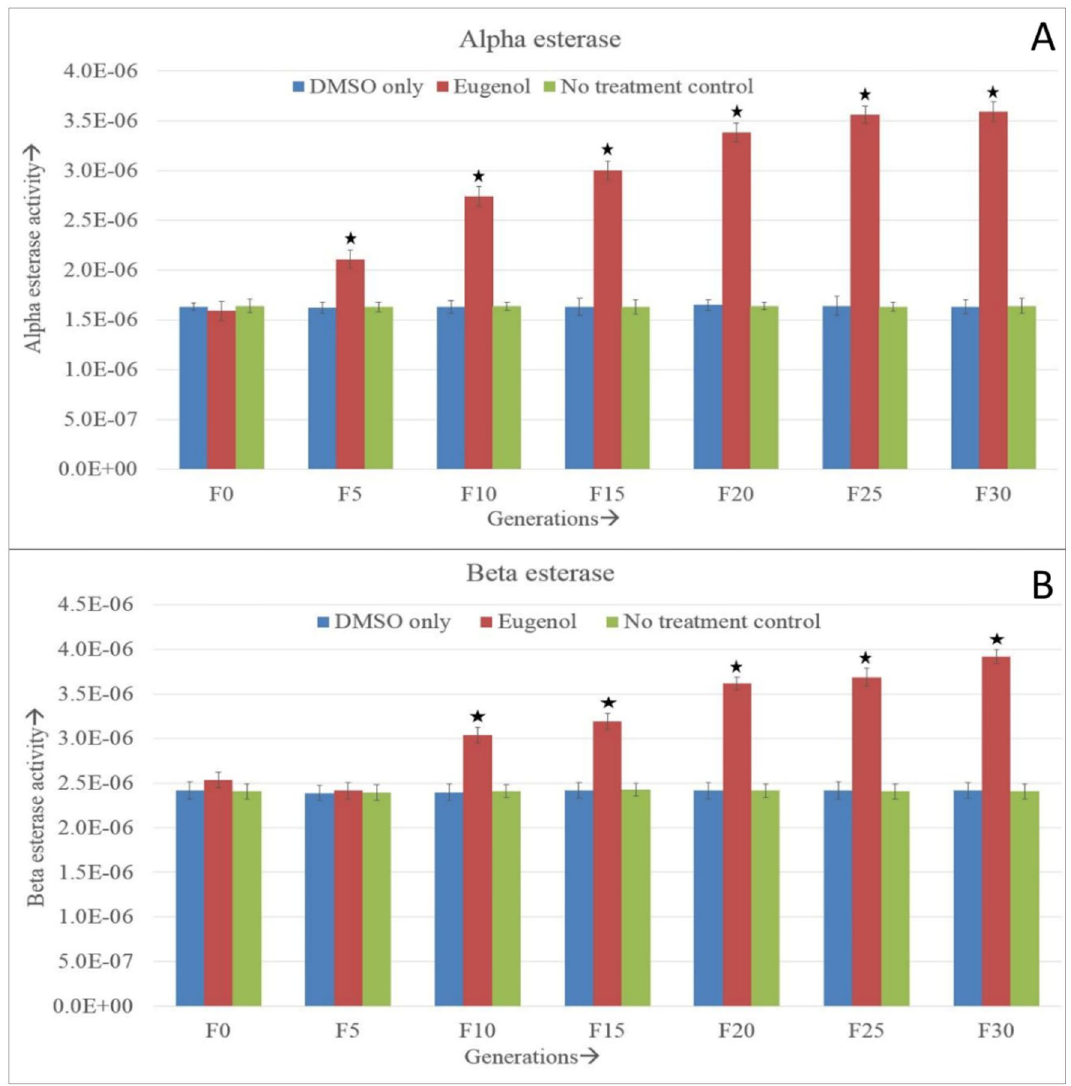
Figure 3. ( A ) α-esterase enzyme activity (± SE), ( B ) β-esterase enzyme activity (± SE) in continuously exposed (F0 to F30) A. aegypti larvae. The asterisks represents the significant difference between the experimental groups. Tukey’s post hoc test was employed to determine the significance in differences. The enzyme activity is expressed at the unit of μM of product formed/min/mg protein. *The mean difference is significant at the 0.05